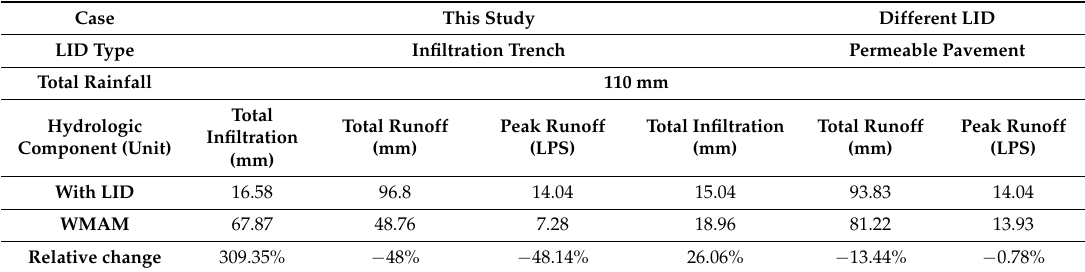
Table 9. Comparison of the WMAM results to different LID types.